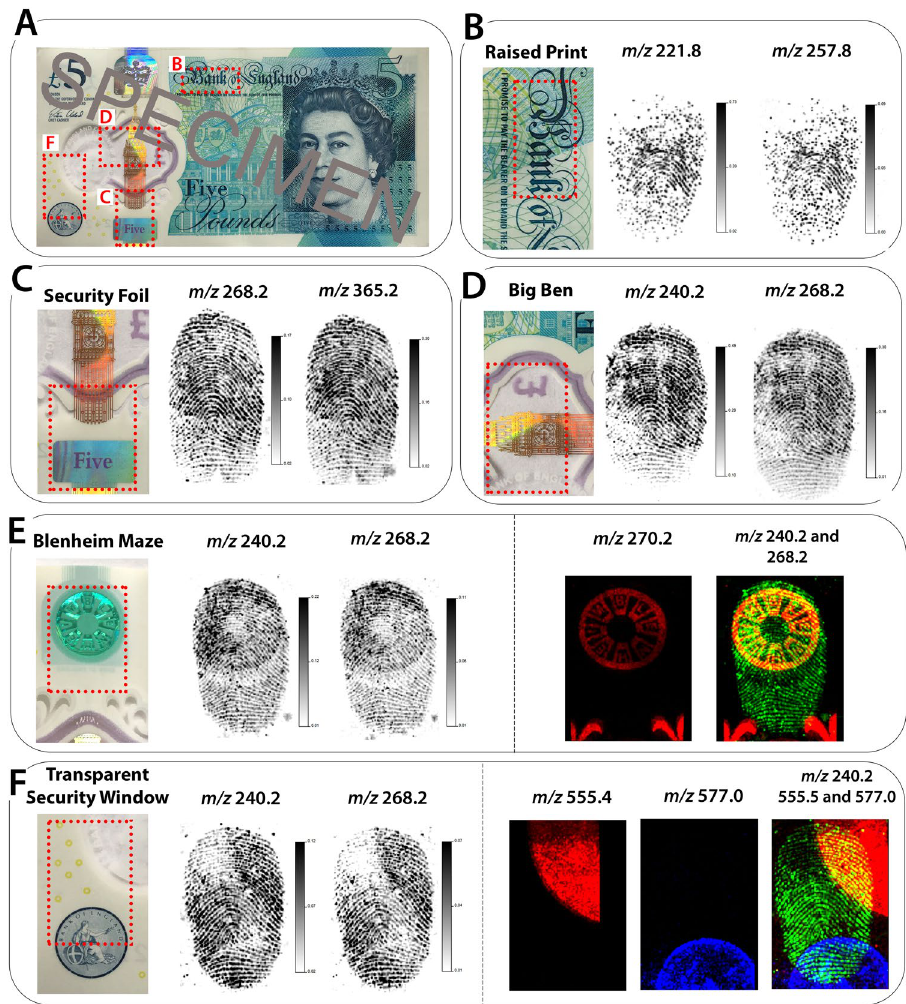
Figure 4. MALDI MSI of fingermarks deposited onto different areas of a polymer banknote. ( A ) An optical image of the Queen side of the banknote and the different areas of the note that were analysed. ( B – F ) Zoom-in of each of the areas where fingermarks were deposited and subsequent MALDI MS images acquired from these regions. The areas include; ( B ) raised print, ( C ) security foil and transparent window, ( D ) Big Ben transparent window, ( E ) Blenheim maze and ( F ) transparent security window. In Panels (E,F), overlapping images have been included to highlight the strong signal obtained from the background security